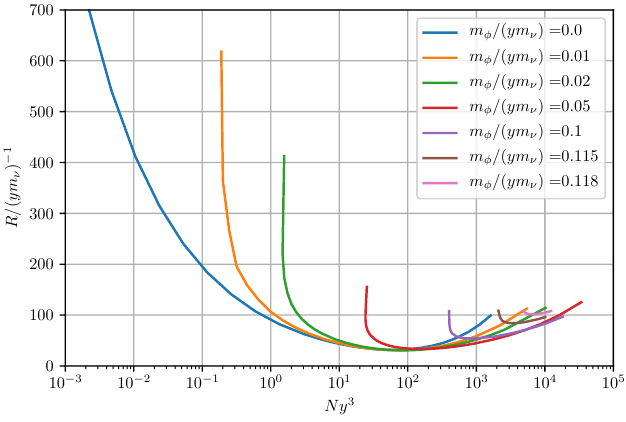
Figure 4 . Dependence of the radius R of a neutrino degenerate cluster in the unit of ym ν on Ny 3 for different values of m φ